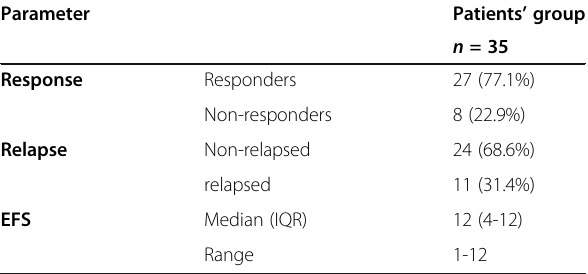
Table 10 Response, relapse, and EFS in AML patients Parameter Patients ’ group